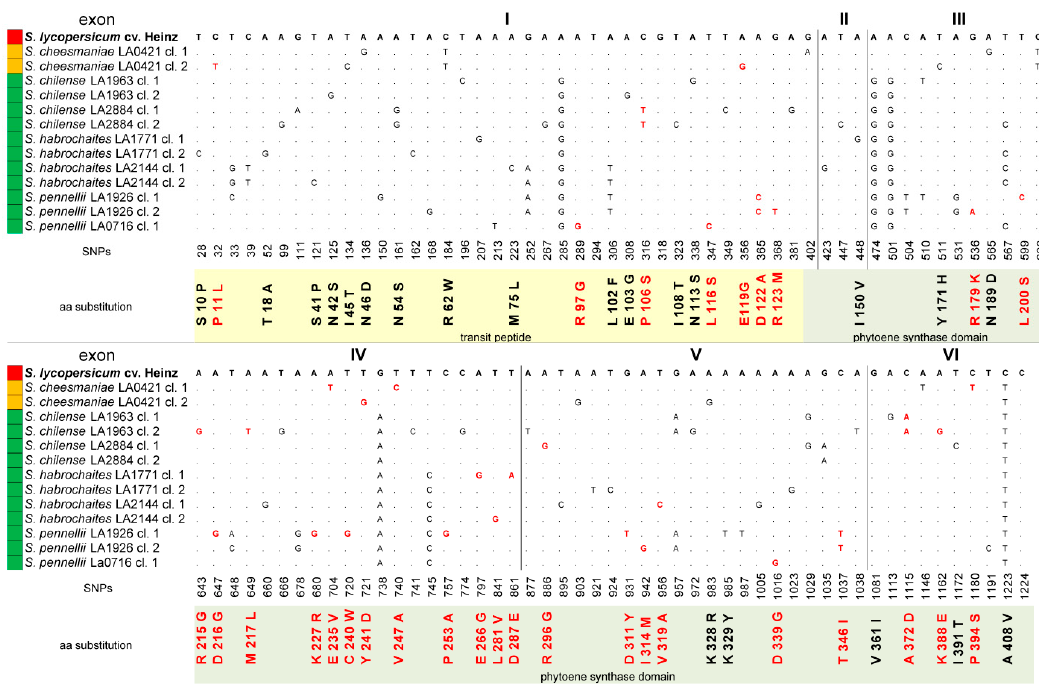
Figure 1. Polymorphisms in identified tomato PSY1 homologs. The numbers indicate the positions of single nucleotide polymorphisms (SNPs) in the PSY1 coding sequences (exons I–VI) relative to S. lycopersicum PSY1 ; the resulting amino acid substitutions in the translated PSY1 proteins are shown below. Non-synonymous SNPs and PROVEAN-predicted radical amino acid substitutions are marked red. Color of the ripe fruit is indicated to the left of the species name.